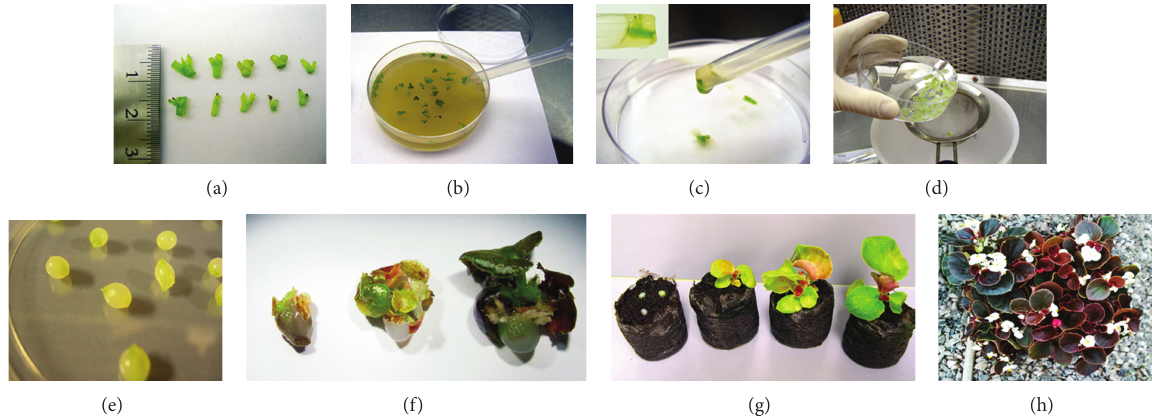
Figure 1: Encapsulation, germination, and maturation of Begonia microshoots. (a) Microshoot explants (4–8 mm long) were excised from in vitro cultures of Begonia cv. Sweetheart Mix and cv. BabyWing White. (b) Explants were submerged in sodium alginate solution for ∼ 2 minutes and then individually suctioned into a sterile, disposable pipette with enough sodium alginate solution to encapsulate. (c) Each explant/sodium alginate combination was then released into a container of CaCl 2 ⋅ H 2 O and left for 30 or 45 minutes. (d) After the allotted time, the calcium chloride was drained from the newly formed synthetic seeds (encapsulated explants) by pouring the mixture into a sterile strainer. The synthetic seeds were rinsed at least three times with sterilized water to remove any remaining CaCl 2 ⋅ H 2 O. (e) Encapsulated explants or synthetic seeds were then placed in one of three container types: empty, sterile Petri dish (for storage), MS media, or peat-based substrate (PBS; Jiffy 7 peat pellets). (f) Typical growth pattern of synthetic seeds in MS media. (g) Typical growth pattern of synthetic seeds in soil. (h) Both MS media and PBS grown synthetic seeds developed into mature, thriving